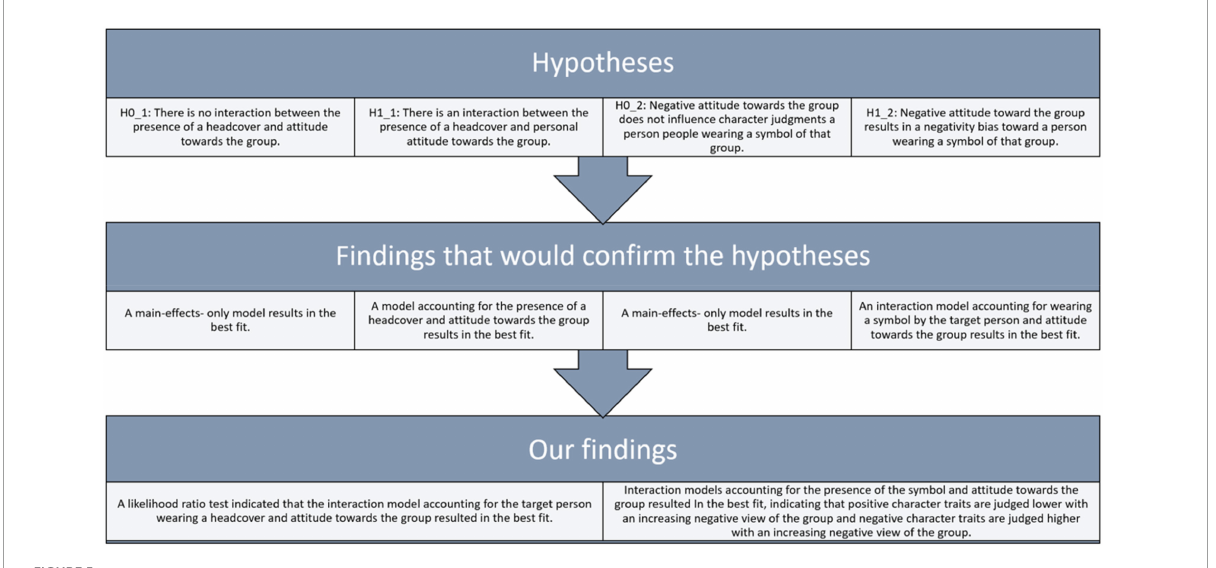
FIGURE5 Hypotheses, predicted observations, and findings for experiment